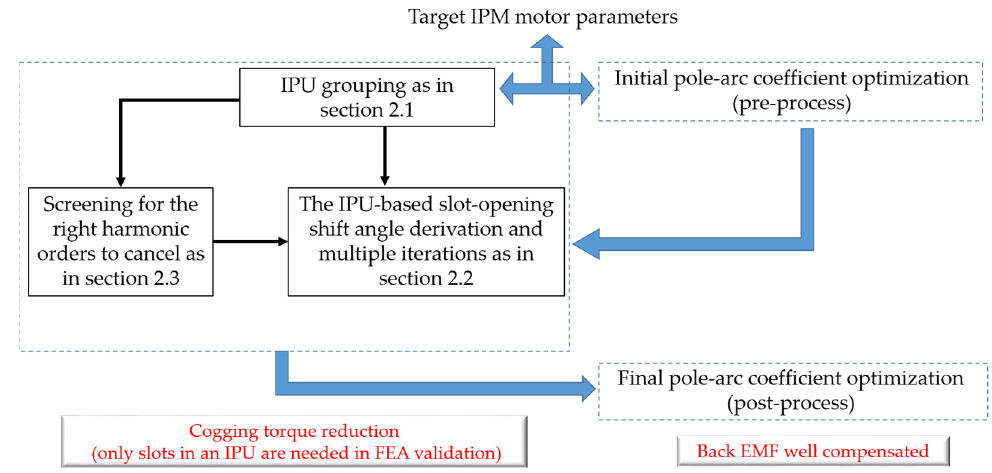
Figure 4. The summary of the proposed cogging torque reduction process.